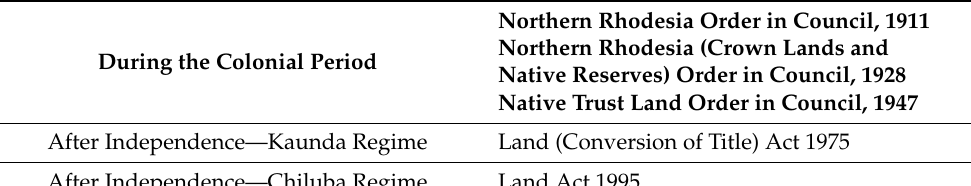
Table 2. Main land laws in different periods in Zambia.